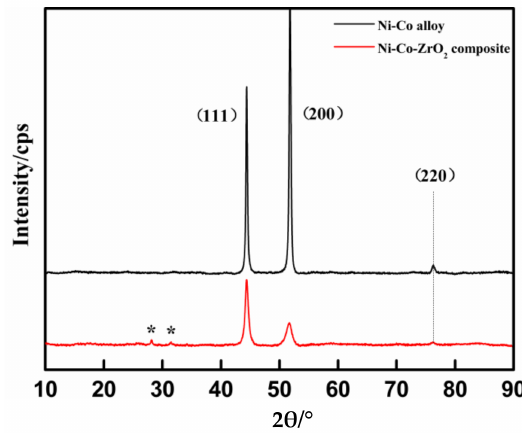
Figure 8. X-ray diffraction patterns for the two